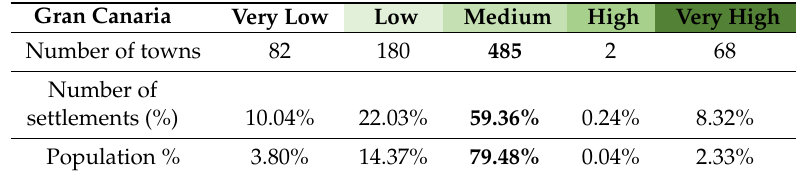
Table 5. Outcomes regarding the demographic dynamics and urban agglomerations classified according to the accessibility levels in the Island of Gran Canaria (Source: authors).